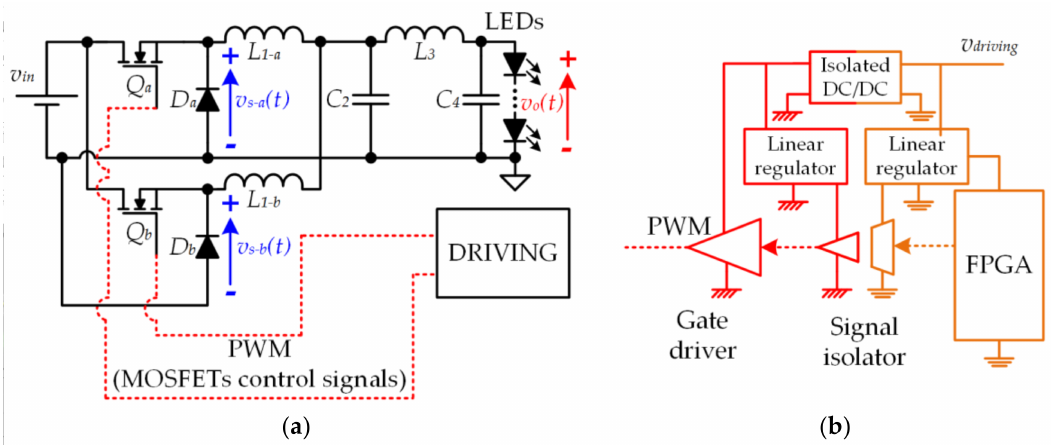
Figure 15. ( a ) Circuit of the two-phase buck converter with a fourth-order output filter; ( b ) Driving system and auxiliary power supply of each phase.